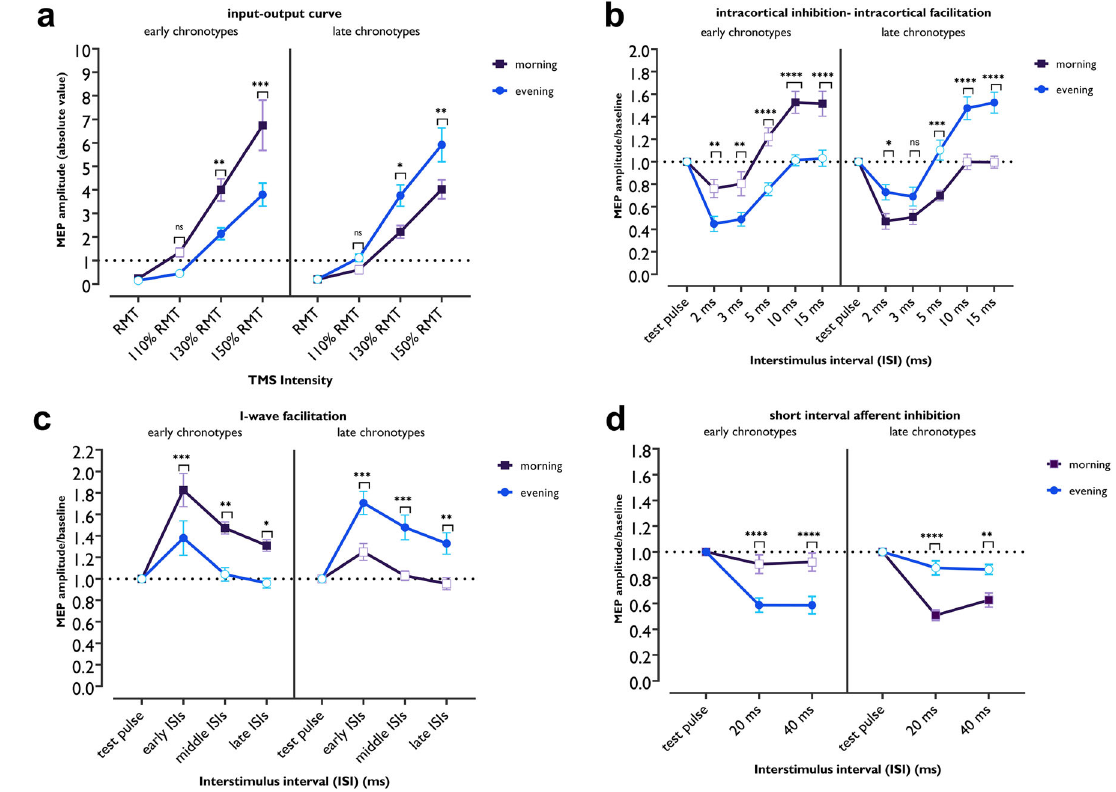
Fig. 2 Monitoring corticospinal and corticocortical excitability with TMS protocols. Cortical excitability data were analyzed using mixed-factorial ANOVAs with repeated measures (see Table 1). a Global corticospinal excitability monitored by MEP amplitudes at different TMS intensities via the I – O curve protocol. ECs showed signi fi cantly higher corticospinal excitability in the morning than in the evening ( t 130% = 3.19, P = 0.004; t 150% = 5.054, P < 0.001), and compared to the same time in LCs ( t 130% = 3.05, P = 0.007; t 150% = 4.67, P < 0.001), and LCs display enhanced excitability in the evening ( t 130% = 2.64, P = 0.026; t 150% = 3.248, P = 0.004), and compared to the same time in ECs ( t 130% = 2.78, p = 0.017; t 150% = 3.63, p = 0.004) a t higher TMS intensities. b Intracortical inhibition and facilitation measured by the SICI-ICF paired-pulse (pp)TMS protocol. Signi fi cantly higher cortical inhibition in the evening and morning were observed for ECs ( t ISI2 = 3.09, p = 0.006; t ISI3 = 3.13, p = 0.005) and LCs ( t ISI2 = 2.57, p = 0.031; t ISI3 = 1.80, p = 0.217), respectively. In contrast, cortical facilitation was signi fi cantly enhanced in the morning, and evening for ECs ( t ISI10 = 5.09, P < 0.001; t ISI15 = 4.79, P < 0.001) and LCs ( t ISI10 = 4.71, P < 0.001; t ISI15 = 5.23, P < 0.001), respectively. c I-wave facilita t ion for monitoring GABA-dependent intracortical inhibition. Cortical excitability was signi fi cantly facilitated for early, middle, and late ISIs in the morning for ECs ( t early = 3.84, P = 0.009; t middle = 3.70, P = 0.001; t late = 2.992, P = 0.018) and in the evening for LCs ( t early = 3.92, P = 0.007; t middle = 3.85, P = 0.009; t late = 3.214, P = 0.009), indicative for less cortical inhibition. d Inhibitory effect of peripheral nerve stimulation on motor cortical inhibition, as measured by SAI. ECs showed more prominent cortical inhibition in the evening ( t ISI20 = 4.76, P = 0.001; t ISI40 = 4.99, P < 0.001), whereas LCs showed more cortical inhibition in the morning ( t ISI20 = 5.50, P < 0.001; t ISI40 = 3.56, P < 0.001). All pairwise comparisons were calculated using Bonferroni-correc t ed t tests (two-sided). n = 32 (16 per group). Data are presented as mean values ± SEM (standard error of means). Filled symbols represent a signi fi cant difference of MEP amplitudes compared to the respective test pulses (for SICI-ICF, I-wave, SAI) or MEP at RMT intensity (for I-O curve). Asterisks [*] represent statistically signi fi cant comparisons of each outcome measure across time of day for each group. ECs early chronotypes, LCs late chronotypes, MEP motor-evoked potential, RMT resting motor threshold, ms milliseconds; I – O curve input – output curve, ISI interstimulus signi fi cant interactions of chronotype × daytime stimulation × chronotype × daytime and stimulation × chronotype × daytime × timepoint ( F 6.78 = 10.82, P = 0.001; η p 2 = 0.28) but no interac- tion of stimulation × chronotype and timepoint × chronotype.